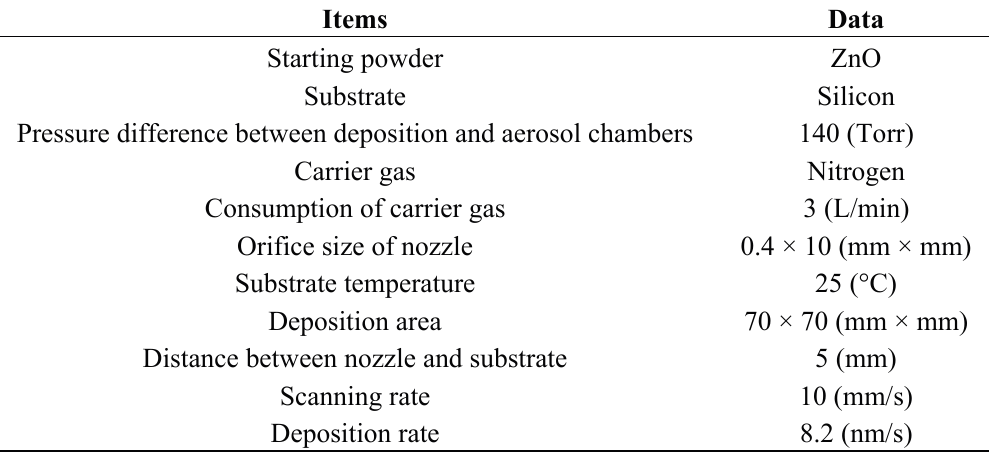
Table 2. Process parameters for ZnO films deposited by the AD